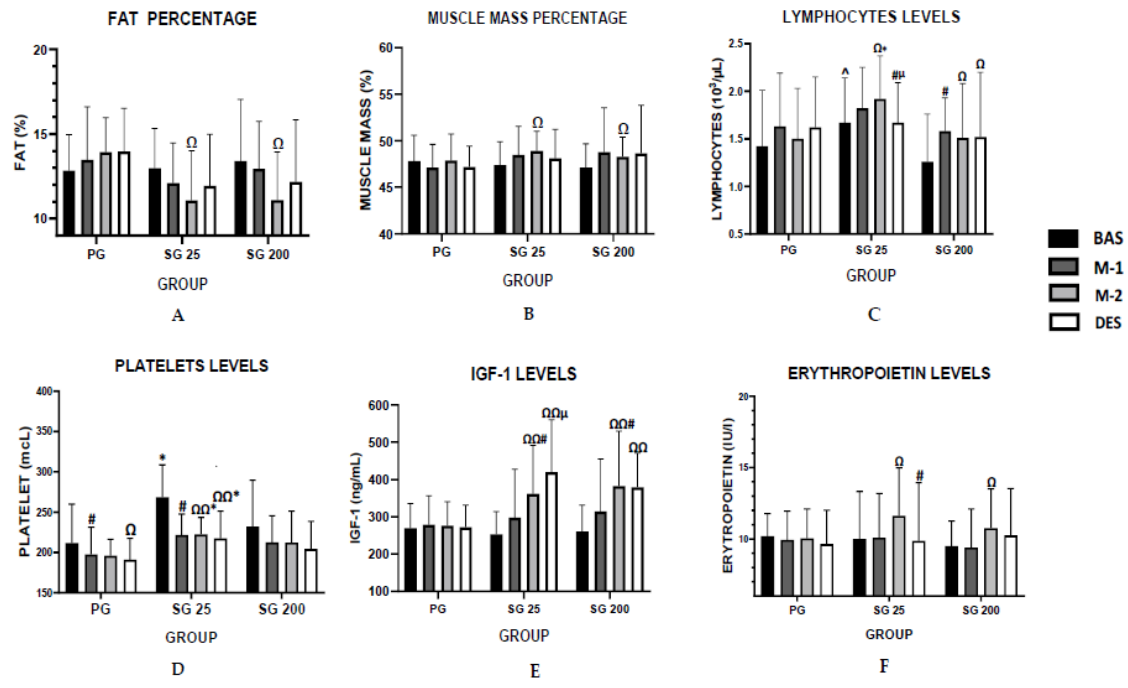
Figure 1. Key values: ( A ) fat percentage in the different evaluations; ( B ) muscle mass percentage in the evaluations; ( C ) lymphocytes levels in the different evaluations; ( D ) platelet levels evolution during the experimental period; ( E ) IGF-1 levels in the different evaluations; ( F ) erythropoietin levels in the different evaluations; SG 25: 25 mg group; SG 200: 200 mg group; BAS: baseline; M-1: month 1; M-2: month 2; DES: desadaptation; # p < 0.05 differences with respect to previous evaluation (paired samples Wilcoxon test); µ p < 0.05 differences desadaptation vs. month 1 (paired samples Wilcoxon test); Ω p < 0.05 desadaptation or month 2 vs. baseline (paired samples Wilcoxon test); Ω Ω p < 0.01 mismatch or month 2 vs. baseline (paired samples Wilcoxon test); * p < 0.05 differences placebo vs. SG 25 or SG 200 (Mann–Whitney U test; ˆ p < 0.05 differences SG 25 vs. SG 200 (Mann–Whitney U